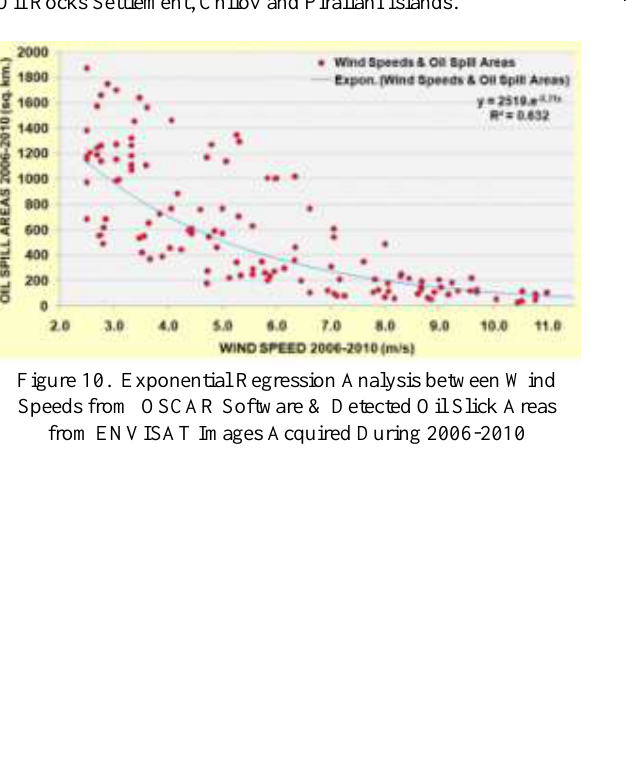
Figure 12. (a) Normalized radar cross Section 1 and wind speed (b) normalized radar cross Section 2 and wind speed.